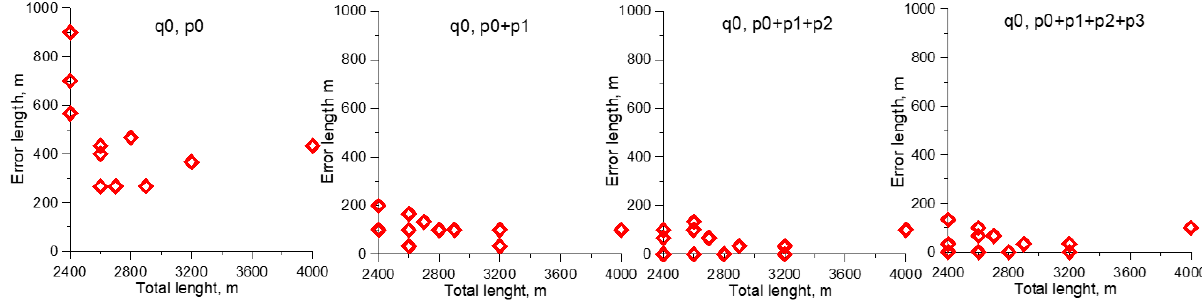
Figure 12. The average length of the error relative to the number of loops and the number of monitoring sensors applied.